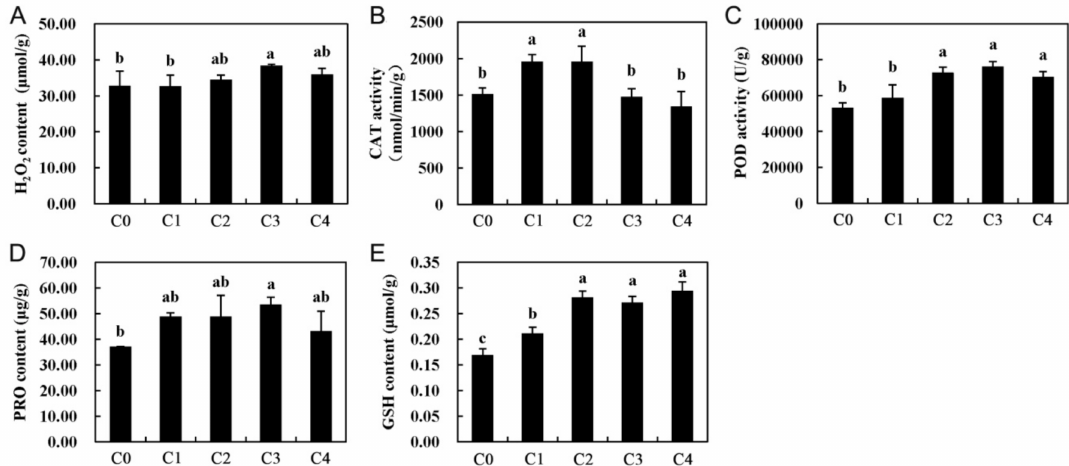
Figure 8. Physiological indices of whole alfalfa seedlings after 0, 2, 6, 24, and 48 h of cold stress. ( A ) H 2 O 2 content, ( B ) CAT activity, ( C ) POD activity, ( D ) PRO content, and ( E ) GSH content. Whole seedlings were sampled from plants subjected to 4 ◦ C for 0, 2, 6, 24, and 48 h. Additionally, C0, C1, C2, C3, and C4 represent 0, 2, 6, 24, and 48 h, respectively. Each value represents the mean of three replicates ± SD (standard deviation) shown by a vertical error bar. Different letters above the bars indicate a significant a difference at the 0.05 level, according to Duncan’s multiple range